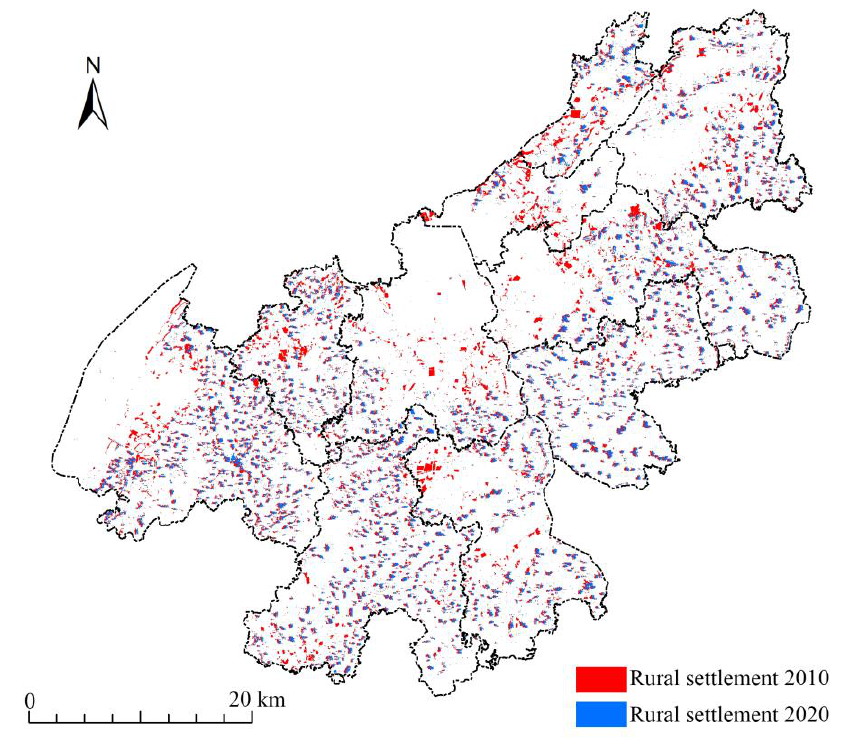
Figure 2. Rural settlements in Jiangning District (2010,